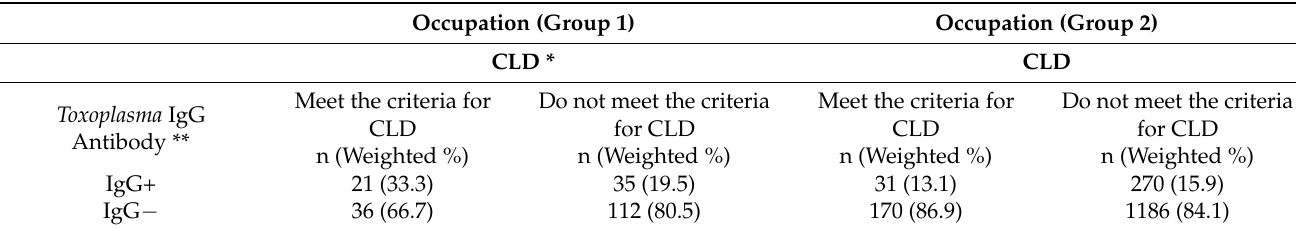
Table 8. T. gondii (IgG+/IgG − ) vs. CLD per occupation (Group 1/Group 2).